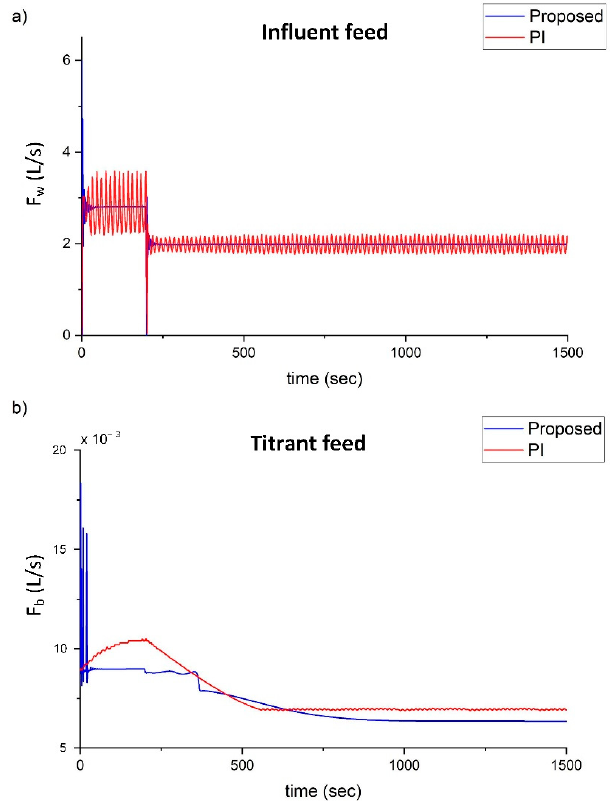
Figure 14. Actions of the coupled control of the pH process: ( a ) influent feed and ( b ) titrant feed. Table 6. The performance comparison between the proposed and PI controllers.